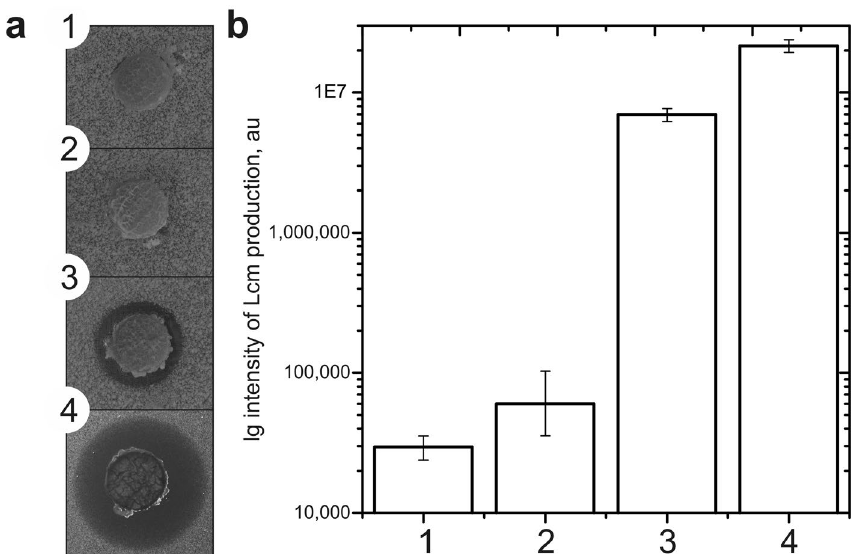
Figure 5. D. hansenii growth inhibition assay ( a ) revealed the activation of Lcm production by S. cyanogenus ΔlanI7 upon introduction of extra copy of lcm cluster-situated transcriptional regulators. Agar plugs were cut from the lawns of S. cyanogenus ΔlanI7 (1), ΔlanI7 lcmRI + (2), ΔlanI7 lcmRII + (3) and ΔlanI7 lcmRIII + (4) grown on YMPG agar for 120 h. Lcm production by the same strains in liquid YMPG was quantified via LC–MS ( b ) in the three recombinant strains as compared to the initial one. Data represent mean values of three independent experiments, error bars are mean values ± 2SD.